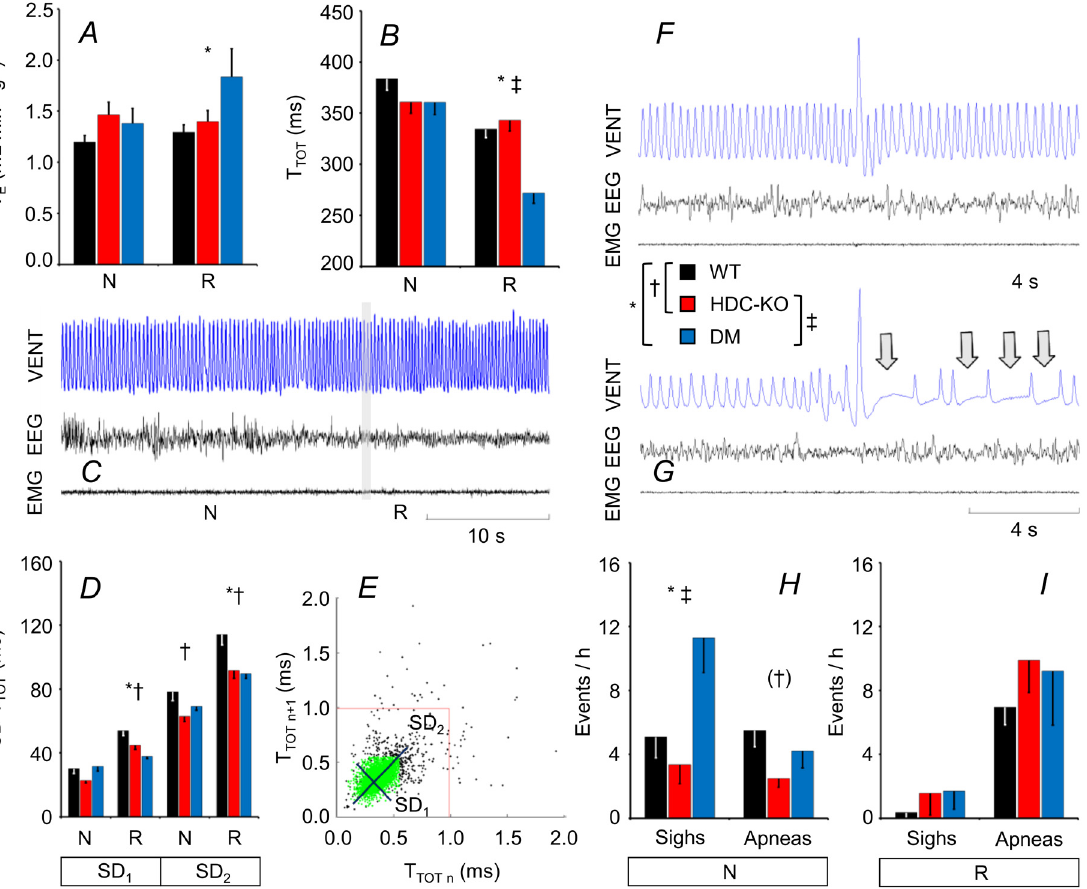
Fig 5. Sleep-related changes in breathing. (A) and (B), values of minute volume (V E ) and breath duration (T TOT ), respectively, during non-rapid-eye- movement sleep (N) and rapid-eye-movement sleep (R). In this and the other panels, data are means ± SEM in HDC-KO (n = 11 during N, n = 10 during R), DM (n = 7), and WT (n = 11). (C) Representative tracing (plethysmographic ventilator signal, VENT; electroencephalogram, EEG; electromyogram, EMG) during a transition from N to R in a DM mouse. The decrease in T TOT during R is evident from the occurrence of more closely spaced deflections of the VENT signal with individual breaths. The grey vertical bar shows the transition point between states. (D) Short-term (SD 1 ) and long-term (SD 2 ) variability of T TOT . (E) Representative Poincaré plot during N in a DM mouse, in which abscissa and ordinate of each point indicate T TOT of successive breaths. SD 1 and SD 2 correspond to the standard deviations around axes (black segments) oriented with or orthogonal to the line of identity of the Poincaré plot, respectively. SD 1 and SD 2 are computed excluding extreme values of T TOT (black points). The red lines mark the threshold for apnea detection (i.e., three times the average T TOT value). (F) and (G), representative tracings during N in a DM mouse showing augmented breaths (sighs) either isolated (F) or followed by breathing pauses (apneas; G, arrows). (H) and (I), frequency of occurrence of sighs and apneas during N and R, respectively. * , † , and ‡ , P < 0.05, WT vs. DM, WT vs. HDC-KO, and HDC-KO vs. DM, respectively (t-tests). In panel H, the symbol ( † ) indicates a statistical tendency for the difference between HDC-KO and WT (P = 0.051, ANOVA; HDC-KO vs. WT, P = 0.017, t-test).